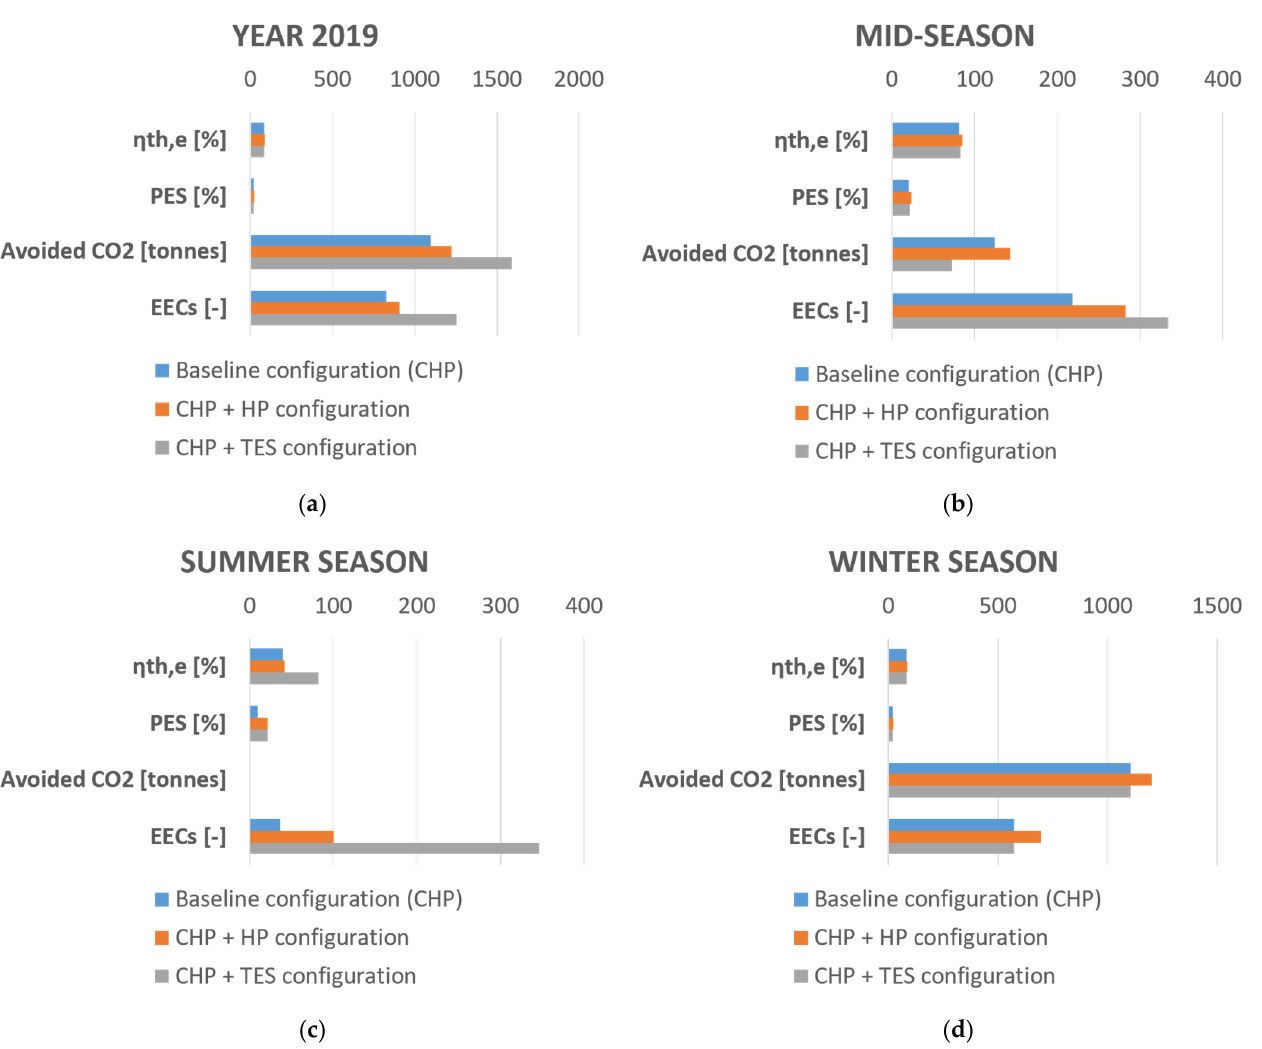
Figure 9. η th,e , PES, Avoided CO 2 and EECs of the total 2019 year ( a ), mid-season ( b ), summer season ( c ), and winter season ( d ) for the CHP-DH plant baseline configuration, configuration with the heat pump (CHP + HP) and configuration with thermal energy storage (CHP + TES).